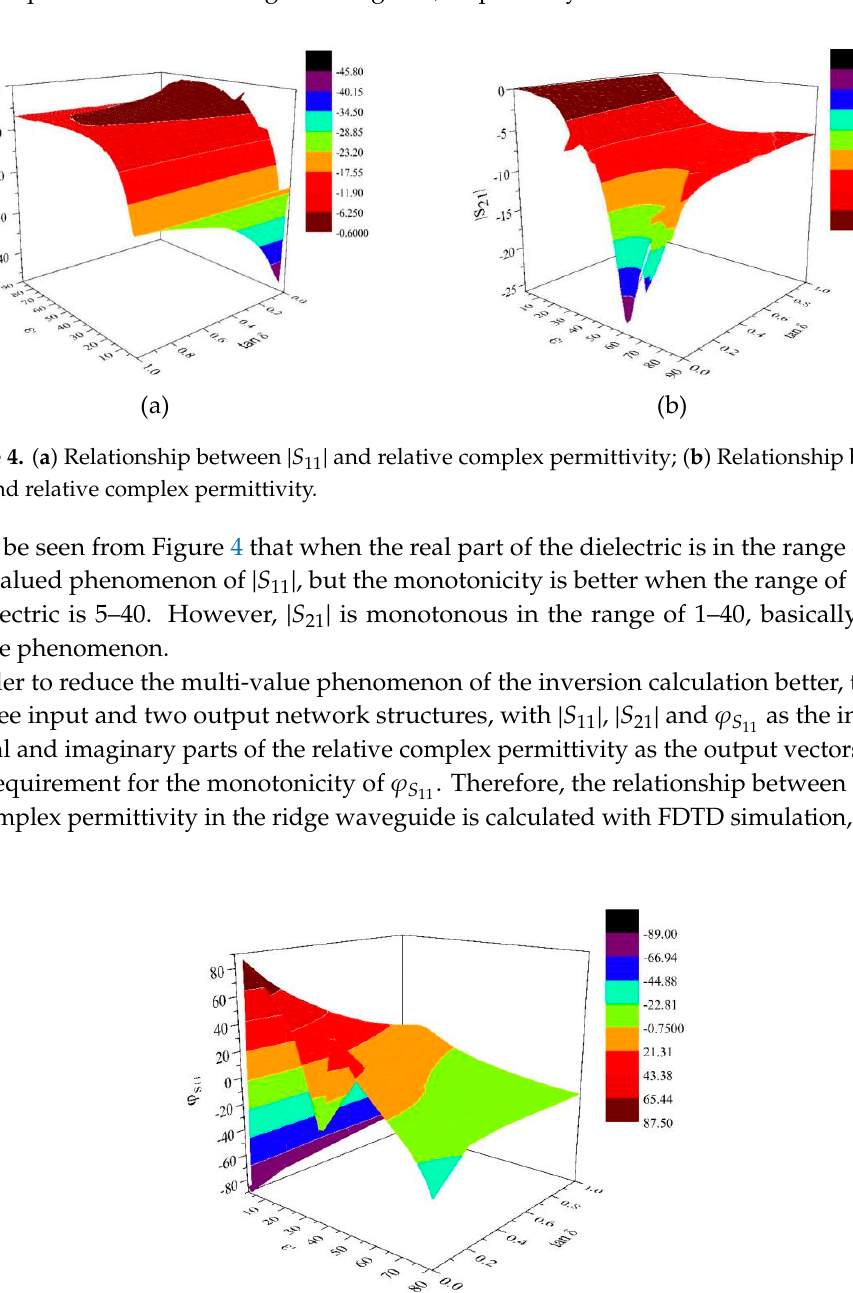
φ and relative complex permittivity. 11 11 S